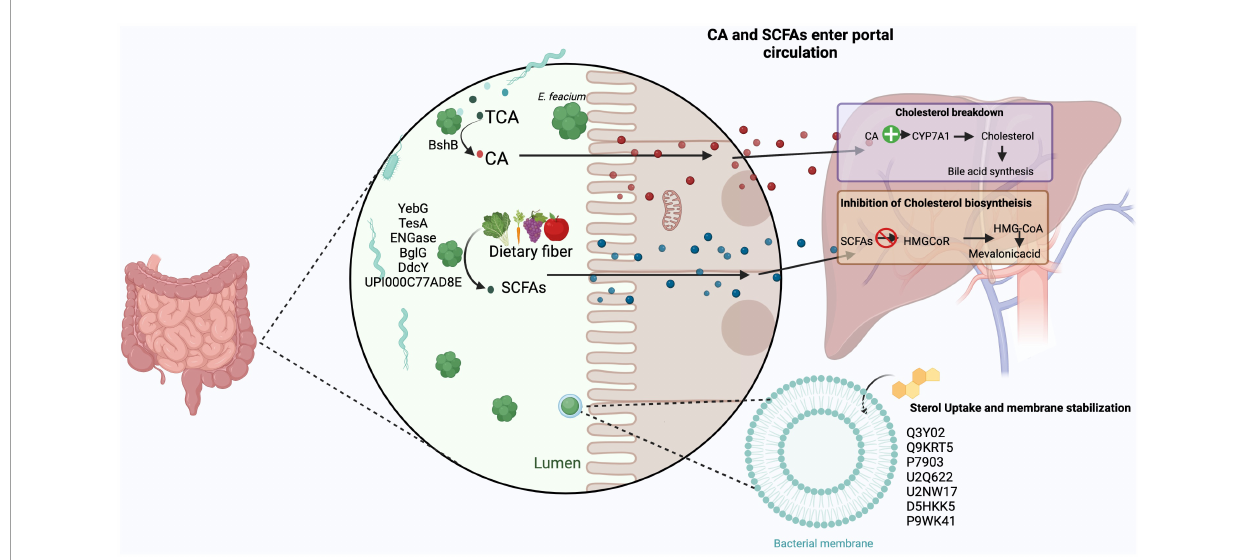
GRAPHICALABSTRACT The three probable mechanisms by which the unique proteins discerned in hypo-cholesterolemic E. faecium LR13 and WEFA23 probiotic strains might aid in cholesterol-assimilation : (i) bile salt hydrolysis : bacterial bile salt hydrolases (BshB) convert taurine/glycine cholic acid (T/GCA) to cholic acid (CA) that aids in the activation of cholesterol 7 α -hydroxylase (Cyp7a) in the liver resulting in degradation of cholesterol into bile acids (110), (ii) production of short chain fatty acids (SCFAs) : the bacterial proteins YebG, TesA, ENGase, BglG, DdcY, and UPI000C77AD8E are involved in the uptake and breakdown of dietary fibers into short chain fatty acids (SCFAs) like propionate, acetate and butyrate. In the liver, these inhibit HMG-CoA reductase enzyme (3-hydroxy-3-methylglutaryl-CoA) which converts HMG-CoA to mevalonic acid resulting in inhibition of cholesterol biosynthesis, and (iii) lipid (sterol) transport, membrane stabilization and binding of cholesterol to the bacterial cell walls : bacterial proteins Q3Y02, Q9KRT5, P7903, U2Q622, U2NW17, D5HKK5, and P9WK41 aid in uptake of sterols (lipids) from the intestinal lumen and incorporation in their cell membranes/walls. Created by